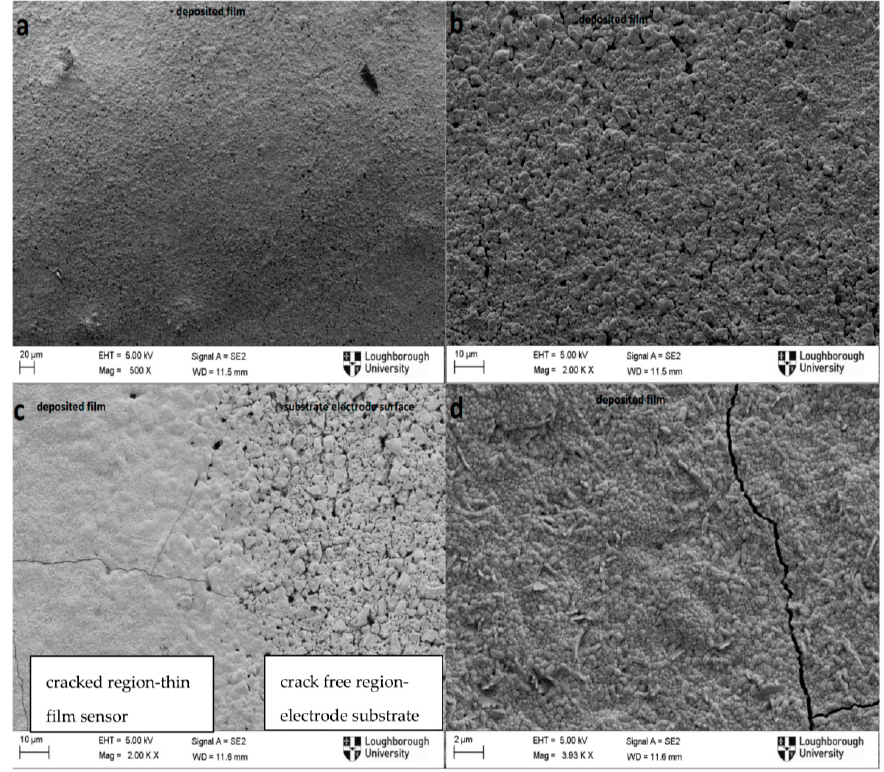
Figure 4. SEM images of 500 nm thick thin film thermoelements before ( a , b ) and after ( c , d ) thermal cycling at 800 °C.